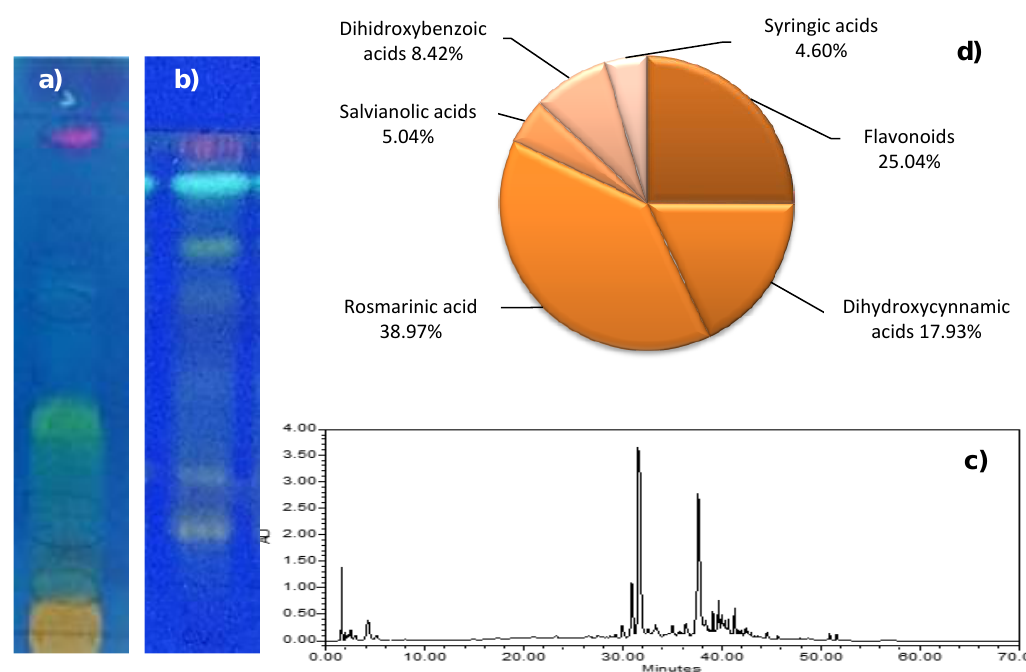
Figure 2. Chemical characterization of ethanolic extract from Origanum vulgare ssp. vulgare . ( a ) TLC plate with ethyl acetate:methanol:water (65:15:5, v/v/v ) as mobile phase, and NP reagent; ( b ) TLC plate with ethyl acetate:glacial acetic acid:formic acid:water (100:11:11:26, v/v/v/v ) as mobile phase, and NP reagent; ( c ) HPLC profile at 325 nm; ( d ) Quantification main groups of compounds expressed as percentage (%).